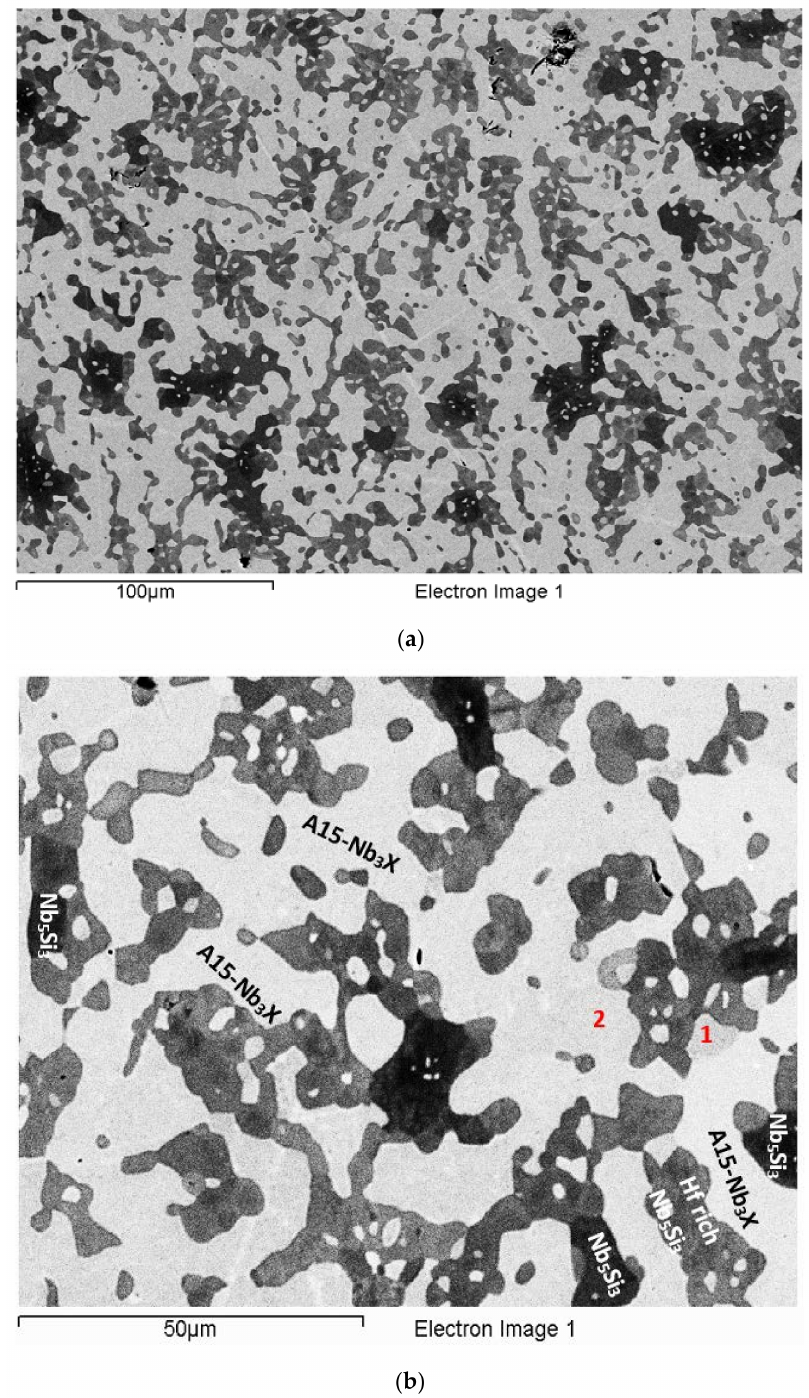
Figure 4. BSE images of the heat-treated alloy EZ5, ( a ) EZ5-HT1, and ( b ) EZ5-HT2. In ( b ), the numbers 1 and 2 indicate A15-Nb 3